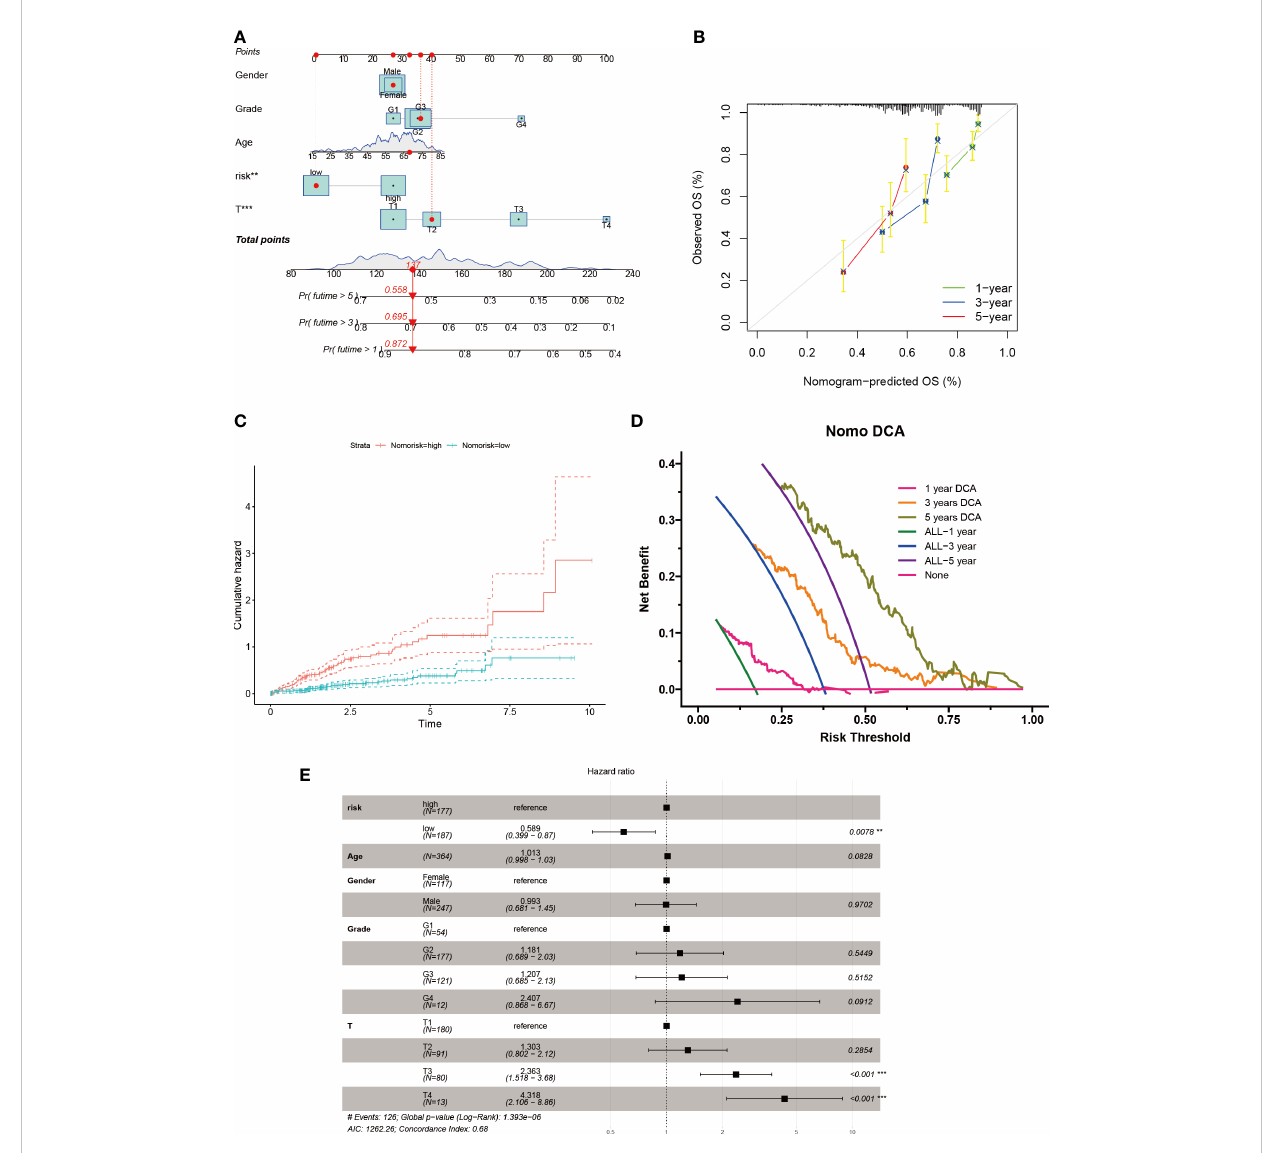
FIGURE 6 Nomogram construction for HCC patients. (A) Nomogram established based on risk scores and clinicopathological features. (B) Calibration plot validates the reliability of this nomogram. (C) Survival probability was represented by the cumulative hazard curve over time. (D) DCA curves of the nomogram for survival status of HCC patients. (E) Multivariable Cox regression analyses of the clinical features as well as risk score in HCC